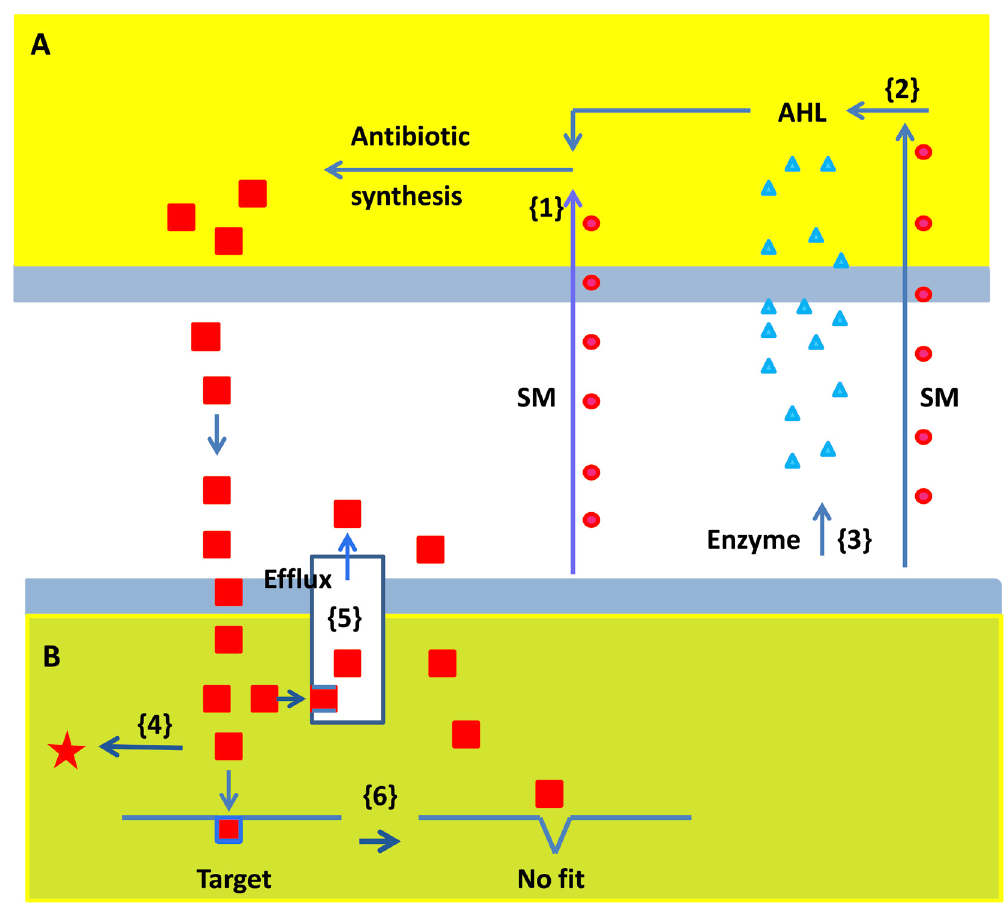
Figure 2. Major mechanisms used by microbes to defend themselves against antibiotic attack by other microbes. Microbe A (top) produces antibiotic molecules (red squares), which enter the antibiotic-sensitive Microbe B (bottom) and fit snugly in their molecular target, thereby inactivating Microbe B (see left part of figure). A variety of mechanisms can be used by Microbe B to defend itself. The numbers in brackets refer here, and in the figure, to the various defense mechanisms. {1} Microbe B can secrete a secondary metabolite (SM), which represses the expression of the antibiotic biosynthetic genes at the level of their promoter. In many cases, acyl homoserine lactones (AHLs) are required for activating antibiotic synthesis (see top right). In such a case, Microbe B can develop one of two different mechanisms. Firstly, it can secrete an SM which inhibits the synthesis of the AHL {2}. Secondly, Microbe B can secrete an enzyme which inactivates the AHL {3}. Also, after the antibiotic has entered Microbe B , B can develop various defense mechanisms. Firstly, it can produce an enzyme which inactivates the antibiotic {4}. Secondly, the antibiotic can be recognized by an efflux pump, by which it is secreted from the cell before it can do much harm {5}. Finally, the receiving microbe can alter its target in such a way that the antibiotic is not recognized any longer {6}. For further explanation, see the section titled “Defense strategies of